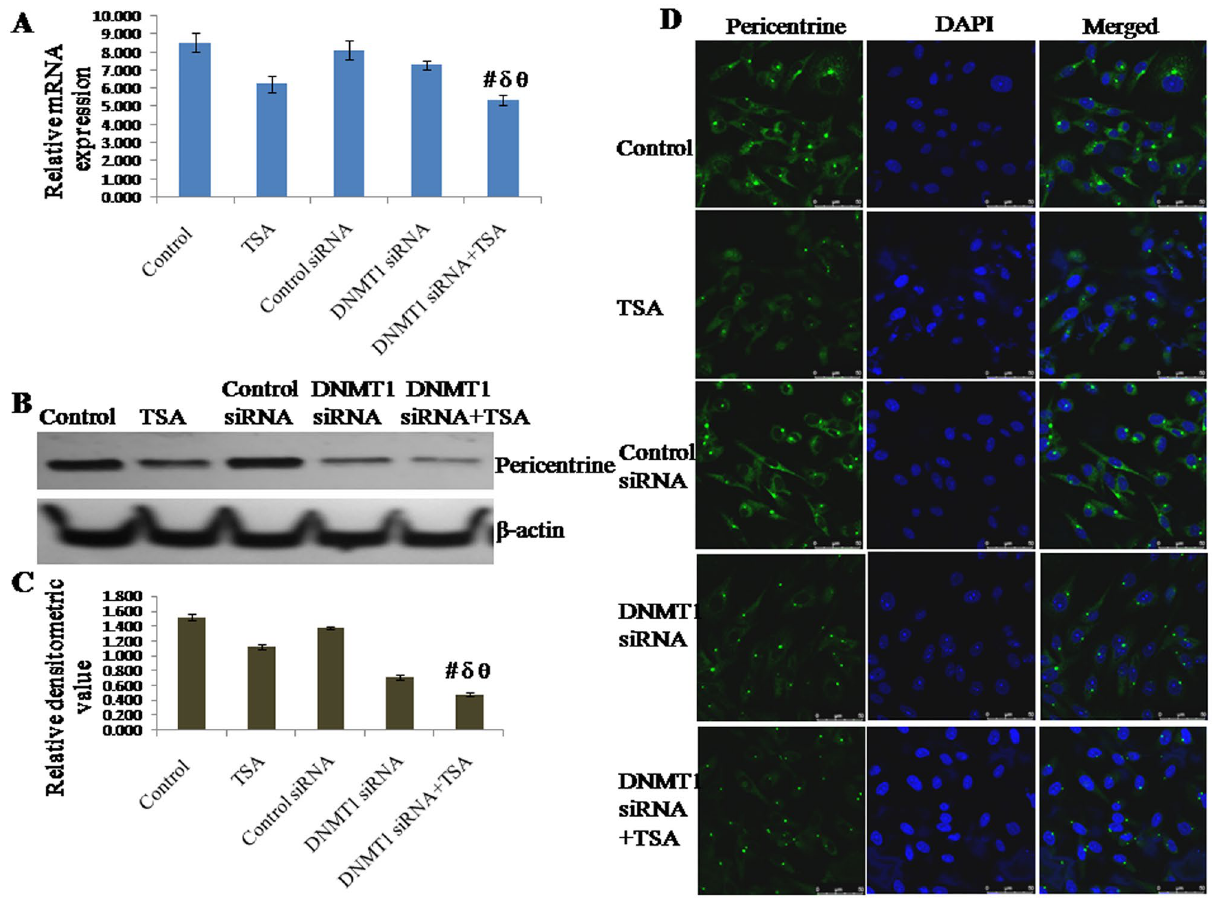
Figure 4. Expression of pericentrine analyzed by ( A ) qRT-PCR using GAPDH as internal control and expressed in terms of relative mRNA expression, ( B , C ) Western blotting using β-actin as internal control and expressed in terms of relative densitometric value, ( D ) immunofluorescent staining and confocal microscopy to observe cellular localization of pericentrin. The representative blots of replicates were presented here. The full-length original images (cropped) of representative blots were presented in the supplementary Fig. S5 of Supplementary information file. Data was represented as mean ± SEM., n = 3, p < 0.05. #, δ and θ represent; compared to control group, TSA treated group and DNMT1 siRNA transfected group